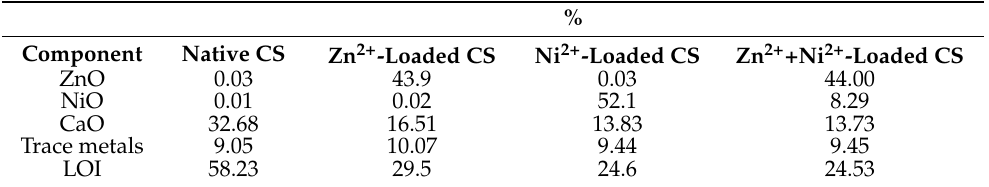
Table 6. XRF analyses of the native, Zn 2+ -loaded, Ni 2+ -loaded, and Zn 2+ +Ni 2+ -loaded CS. % Component Native CS Zn 2+ -Loaded CS Ni 2+ -Loaded CS Zn 2+ +Ni 2+ -Loaded CS ZnO